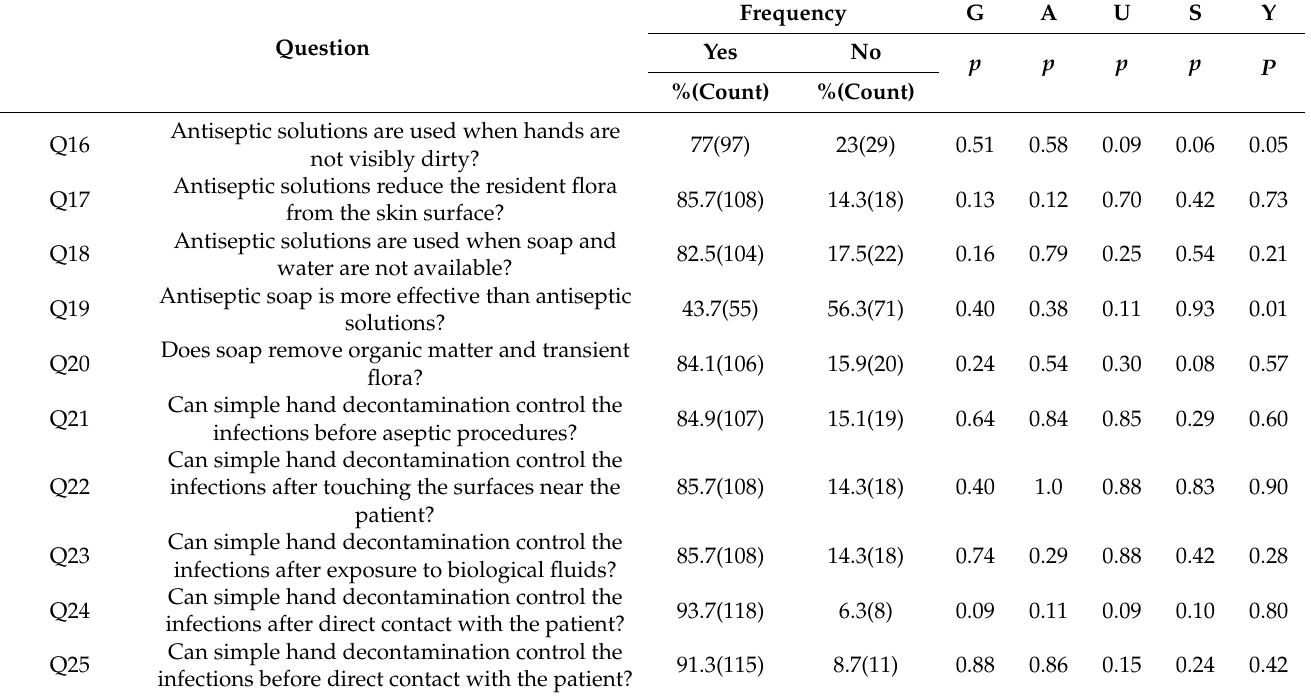
Table 3. Response rate percentage regarding infection control by simple hand decontamination. Results of statistical significance